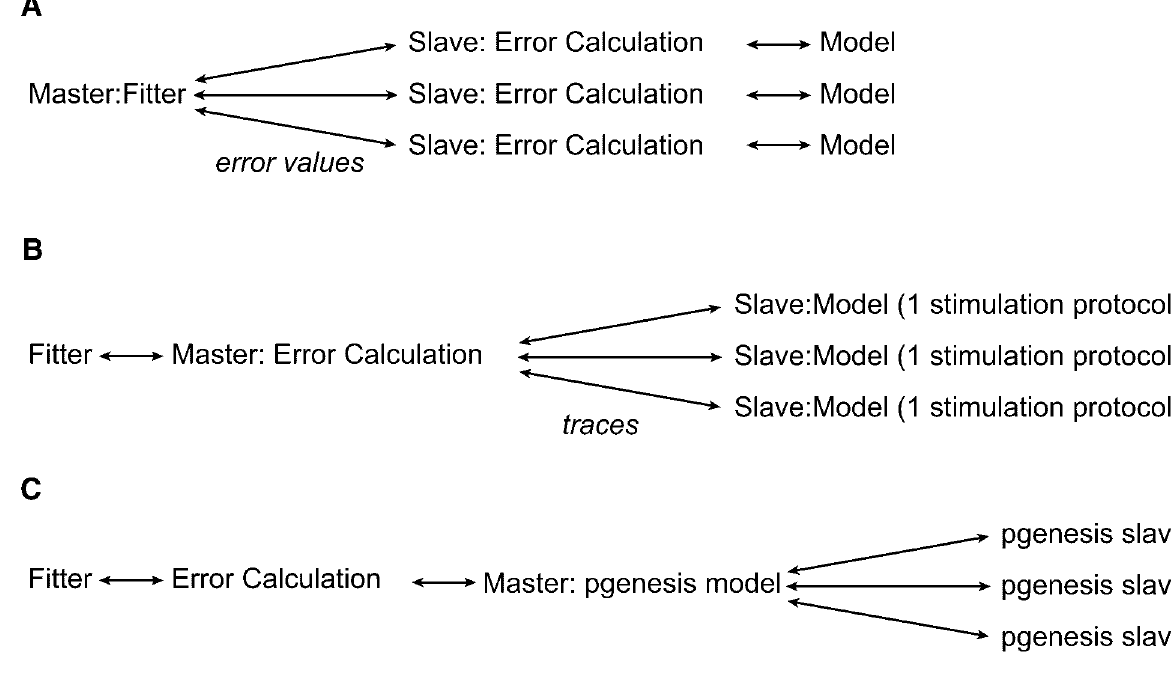
Figure 5. Parallelization . The different levels of possible parallelization. ( A ) All the parallel running slaves receive a set of model parameters, run the model, calculate the error value using the phase-plane trajectory density method, and return the error value to the master node. ( B ) The slaves run 1 stimulation protocol using the model and return the voltage traces to the master. ( C ) The model is internally parallelized in the neuron model